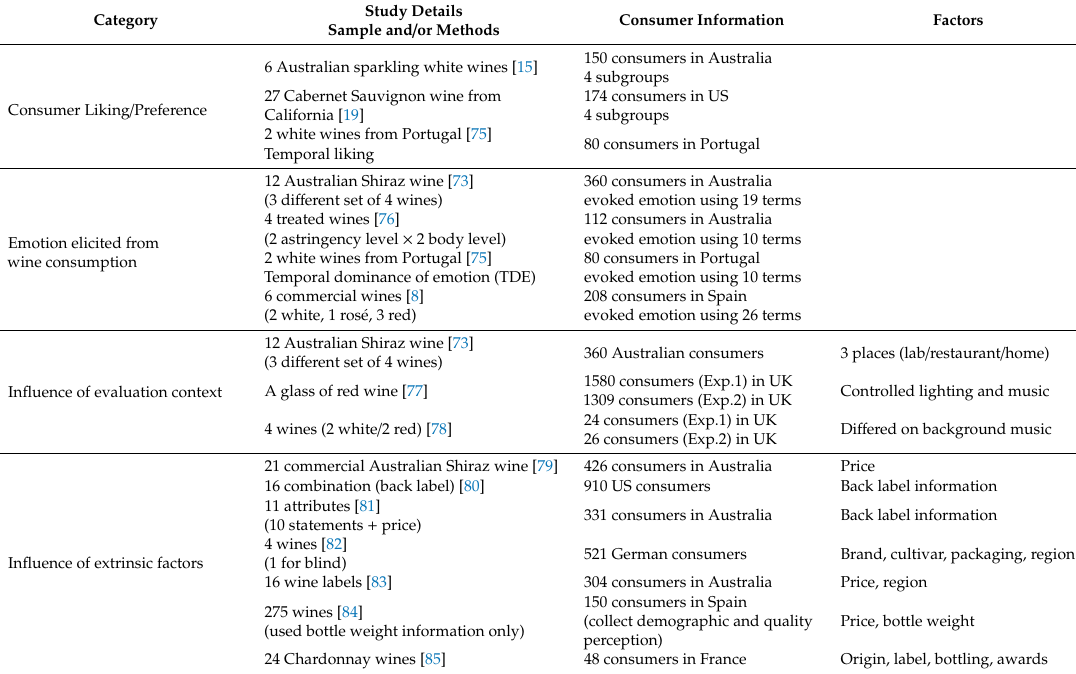
Table 2. Study details and information of consumer